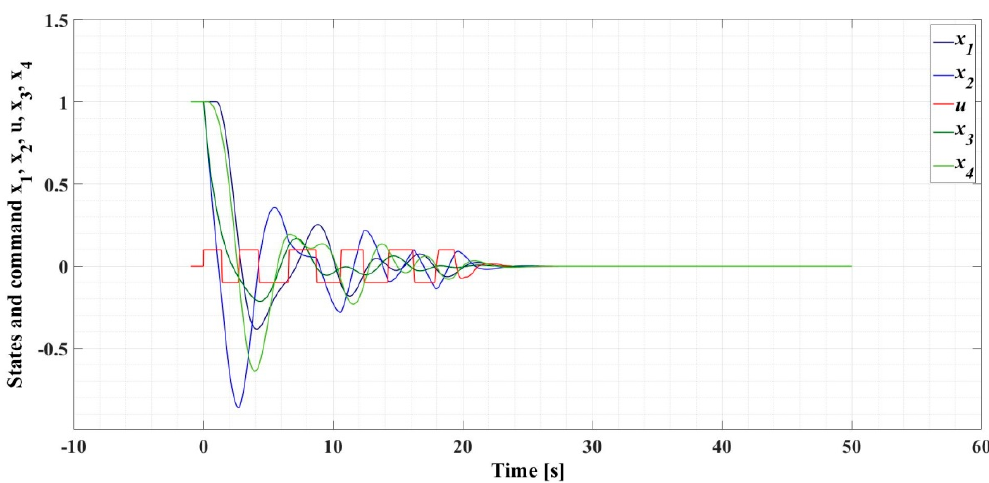
Figure 12. Evolution of the states with ⏐ u ⏐≤ 0.01.